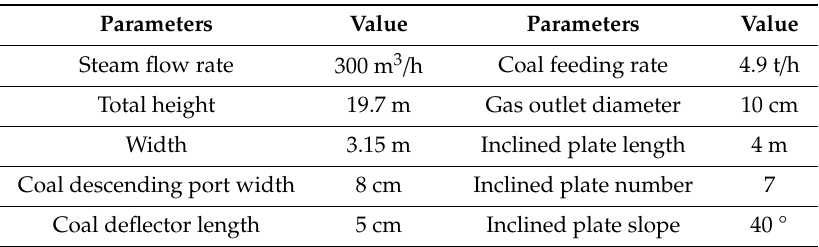
Table 3. Parameters of the moving bed coal